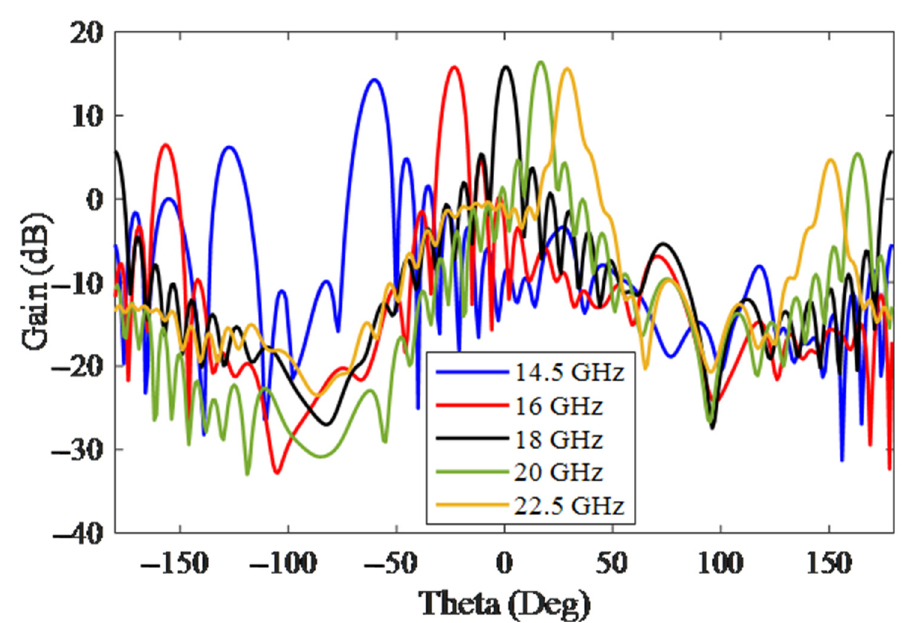
Figure 3. The simulated gain of SIW LWA for five frequencies.